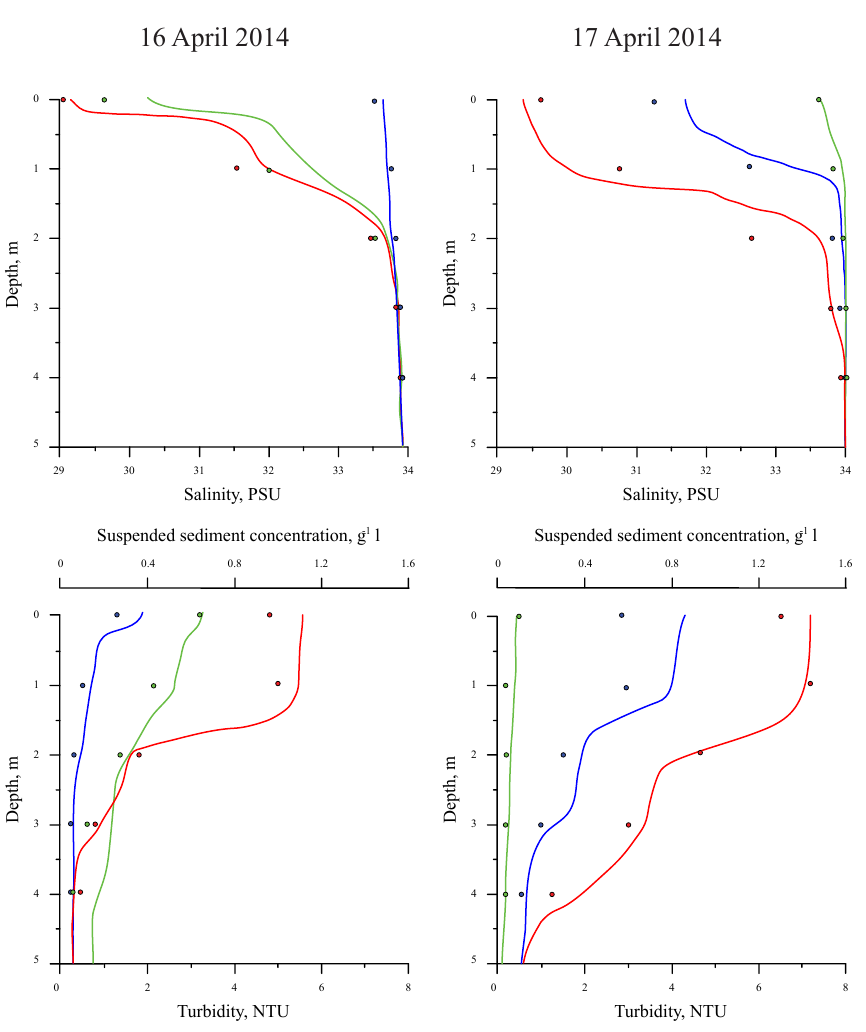
Figure 6. Vertical profiles of salinity (top panels) and turbidity (bottom panels) obtained from the in situ measurements (solid lines) at stations 8 (green), 10 (red), and 12 (blue) on 16 April 2014 (left panels) and 17 April 2014 (right panels) and the related values of salinity (top panels) and suspended sediment concentrations (bottom panels) simulated by the numerical model (circles). A value of 1NTU of the in situ turbidity measurements was assumed to correspond to value of 0.2gL − 1 of the simulated suspended sediment